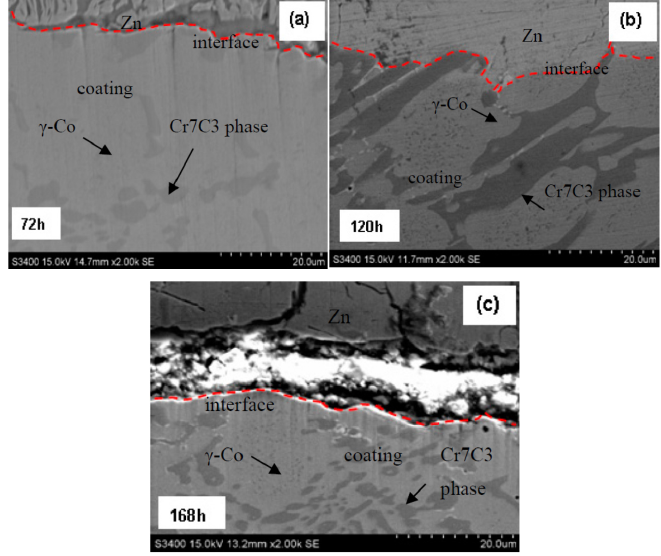
Figure 8. Microstructure of the bushing coating after corrosion tests at: ( a ) 72 h; ( b ) 120 h; ( c ) 168 h.